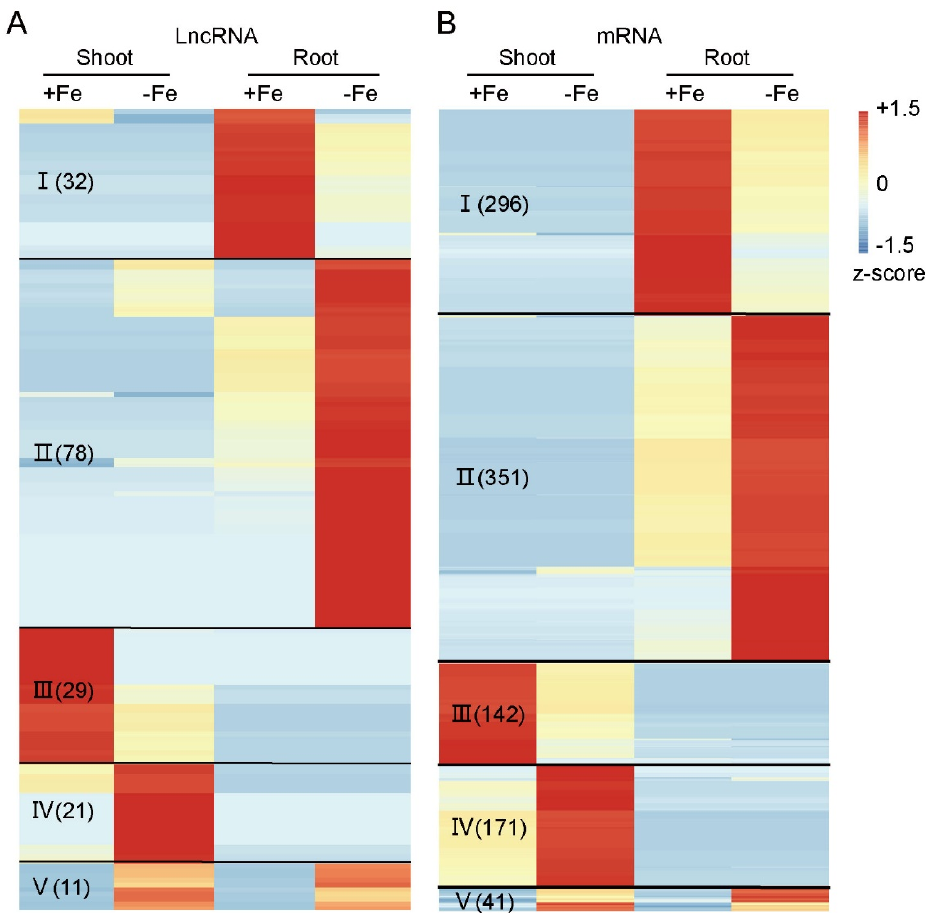
Figure 3. Heatmap of differentially expressed lncRNAs and mRNAs under ± Fe condition in both shoot and root. The lncRNAs ( A ) and mRNAs ( B ) identified as differentially expressed were used to make the heatmap. LncRNAs and mRNAs were divided the into five classes based on their expression patterns. Class I, highly expressed in root and downregulated under Fe deficiency. II, upregulated under Fe deficiency in root. III, highly expressed in shoot and down-regulated under Fe deficiency. IV, upregulated under Fe deficiency in shoot. V, upregulated both in shoot and root. The number of molecules in each class is listed in